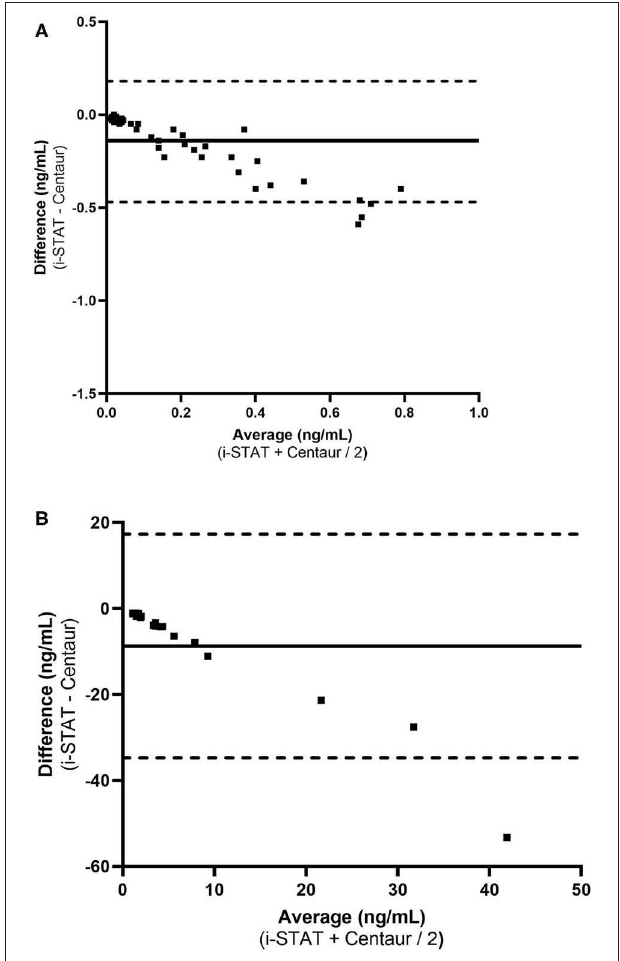
FIGURE 2 | Bland-Altman plots demonstrating measurement difference as a function of measurement for low and high serum cTnI concentrations. (A) cTnI < 1.0ng/mL ( n = 47). (B) Average cTnI ≥ 1.0ng/mL ( n = 18). The horizontal solid line in the center of each graph represent the mean difference (bias) between the methods and the dotted lines represent the limits of agreement between the two methods of